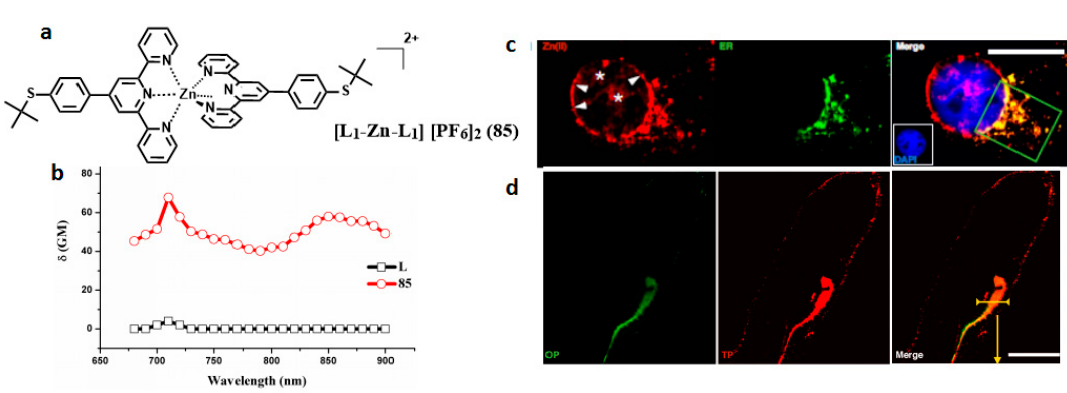
Figure 21. ( a ) Molecular structures of the ligands (L) and its metal complexes ( 85 ); ( b ) 2PA spectra of L and related complex 85 ; ( c ) Two-photon image of HepG2 cells incubated with 40 μ M, λ ex = 700 nm (emission wavelength from 543 to 606 nm) and One-photon image of HepG2 cells incubated with ER tracker, λ ex = 488 nm (emission wavelength from 500 to 550 nm); ( d ) One-photon image of 72 h-zebrafish larva incubated with 30 µ M after 4 h of incubation, washed by PBS buffer, λ ex = 405 nm (emission wavelength from 440 to 480 nm).